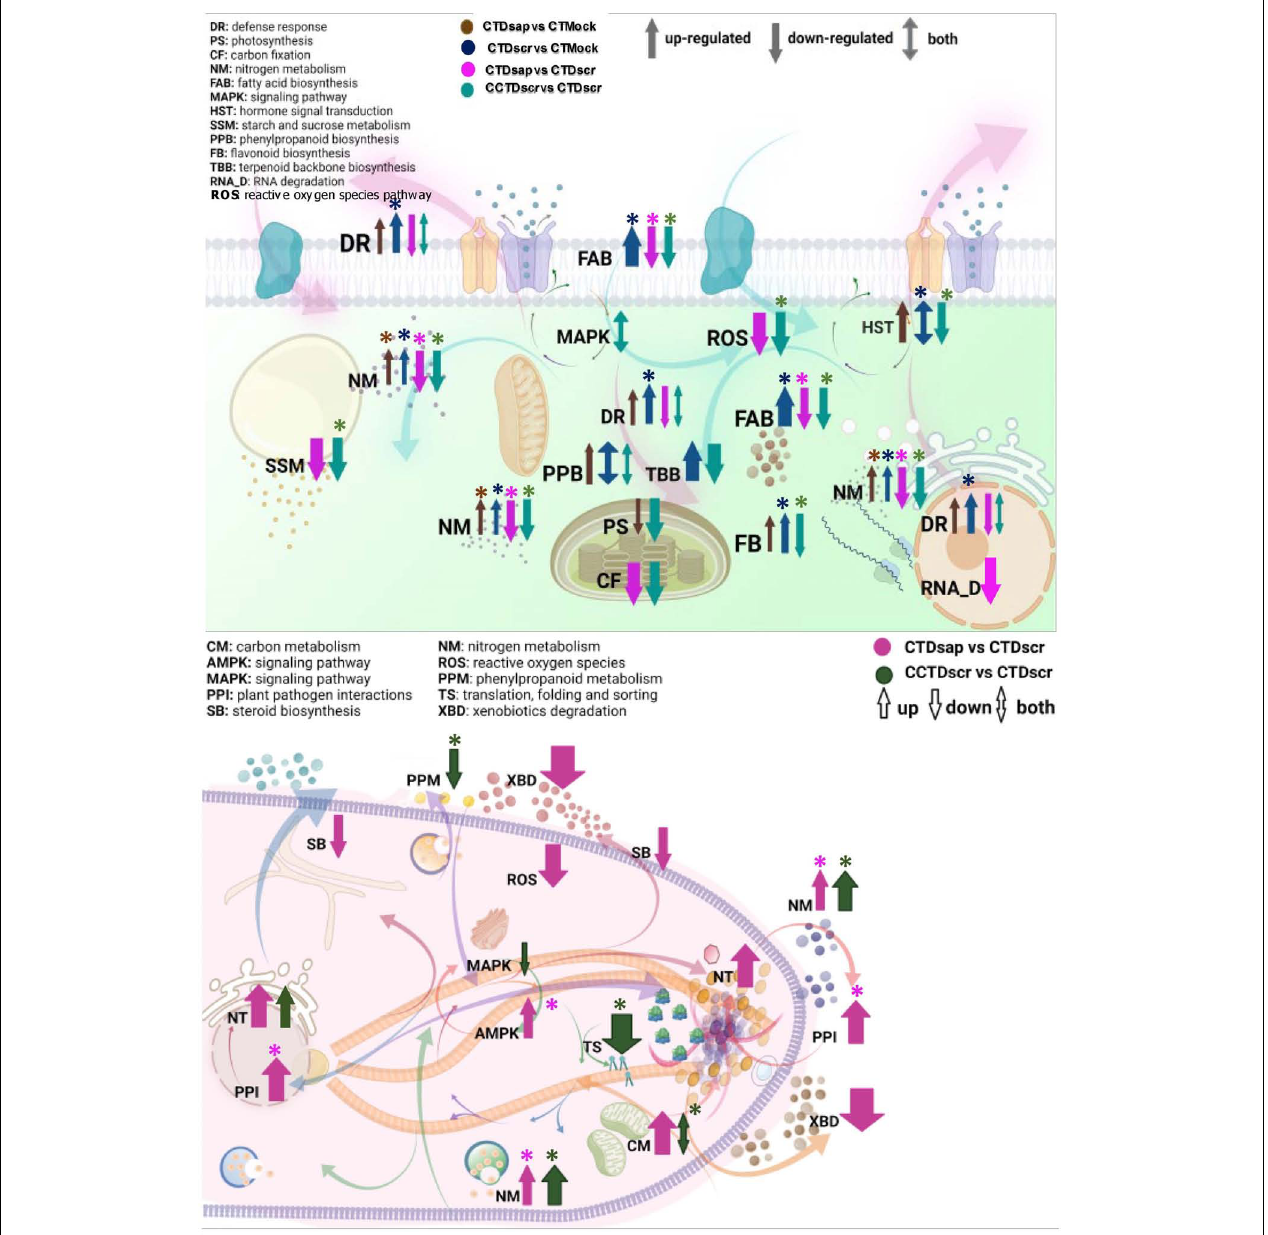
FIGURE 8 | Working models of host (top) and pathogen (bottom) cellular networks of various primary and specialized metabolic pathways. Abbreviations represent GO function and colored arrows indicate respective host and pathogen comparisons. Arrow widths represent arbitrary relative magnitude of changes in significantly expressed DEGs mapped under each pathway for a given host/pathogen comparison. Enriched pathways are marked with